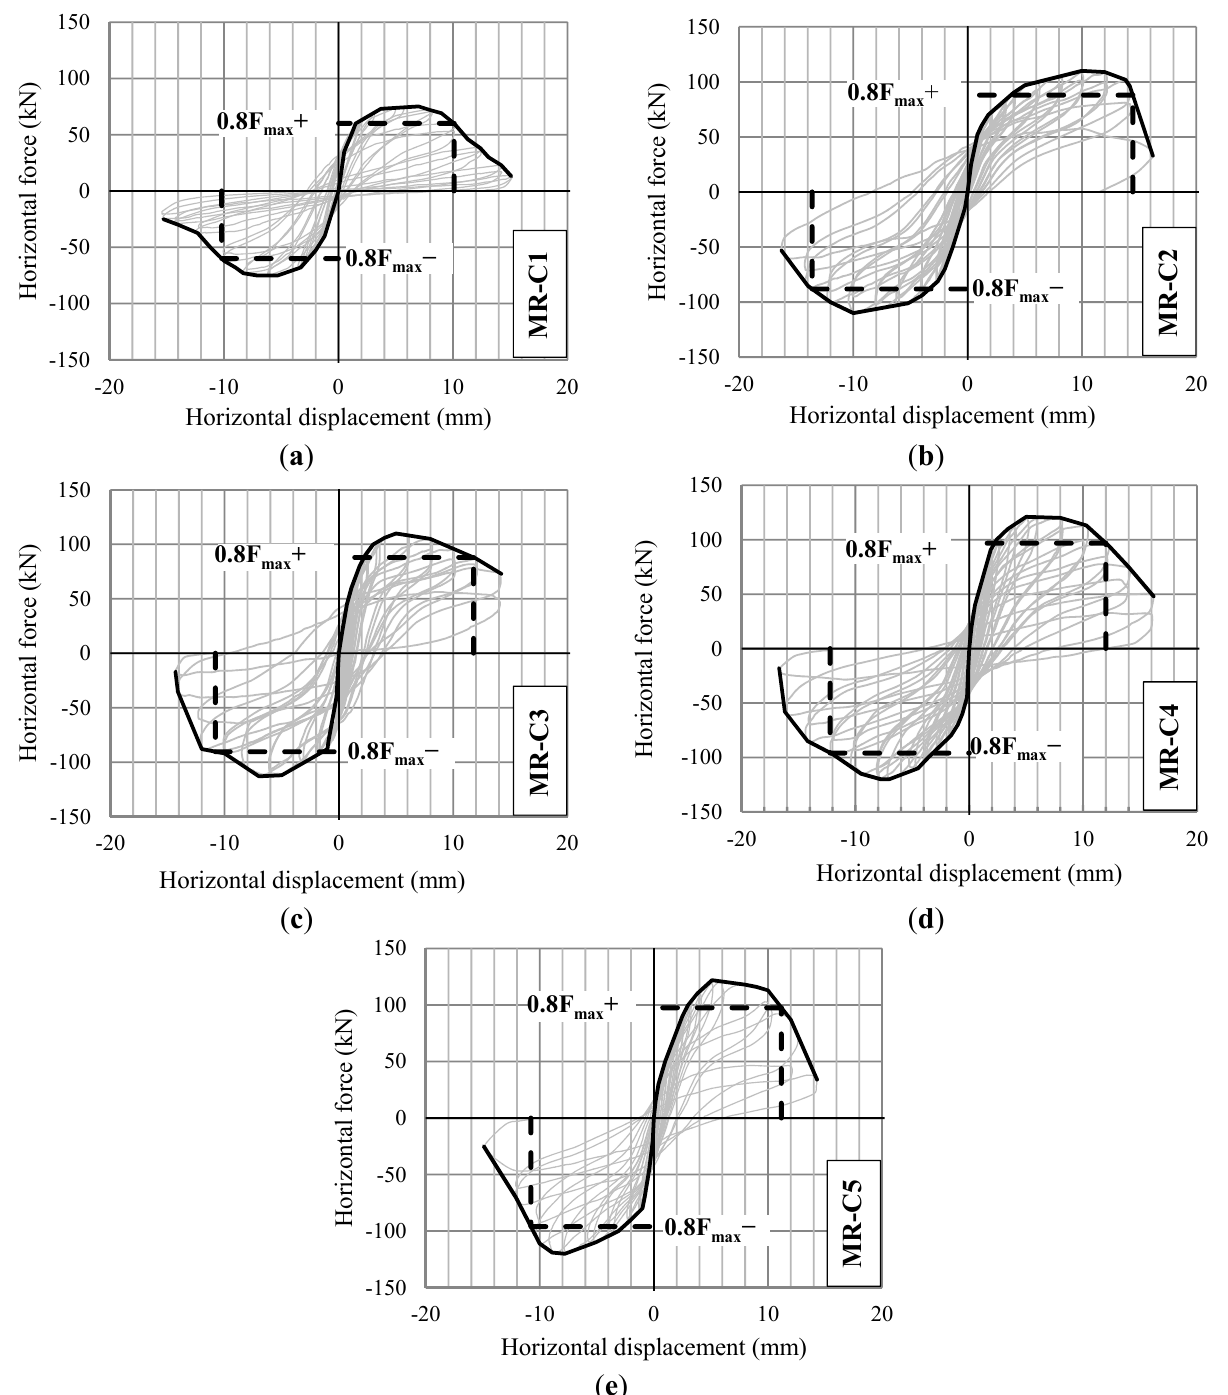
Figure 5. Load-displacement curves in Series MR-C. ( a ) MR-C1; ( b ) MR-C2; ( c ) MR-C3; ( d ) MR-C4; and ( e )